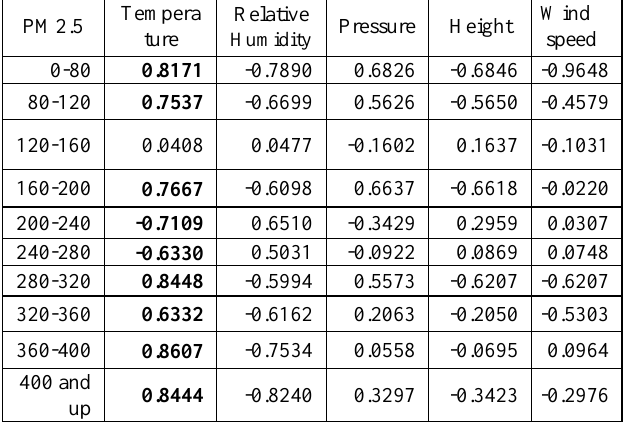
Figure 19. Vertical profile of temperature during the flight